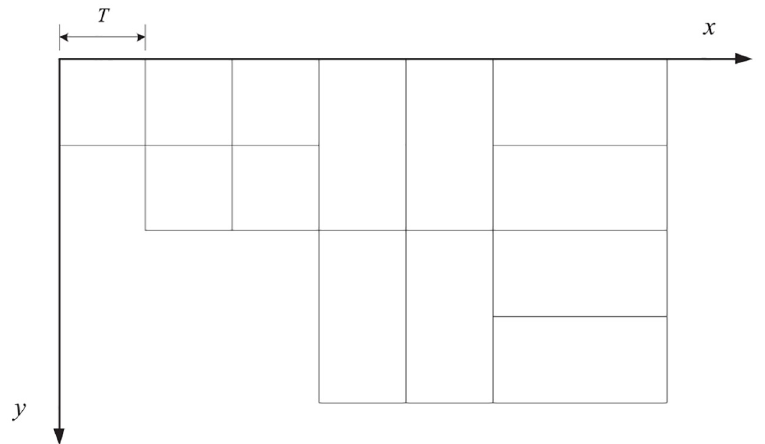
Fig 8. Coordinates of the whole decomposition